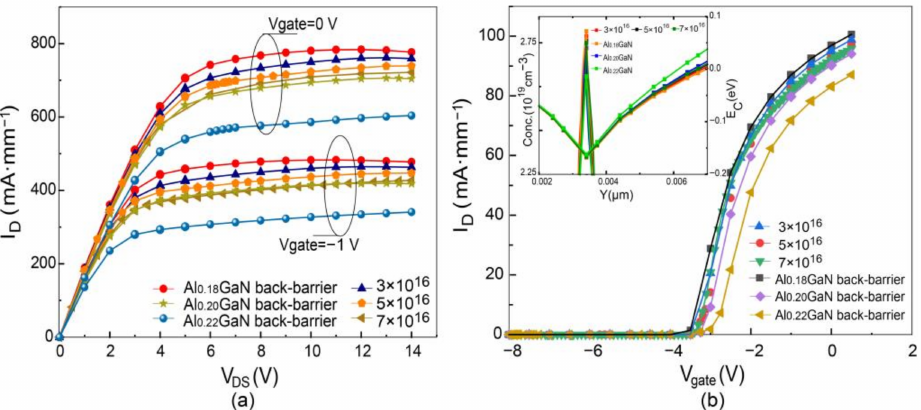
Figure 4. ( a )The output and ( b ) the transfer characteristics of the two structures. The figure in the insert of figure ( b ) is the conduction band and the electron concentration of the two